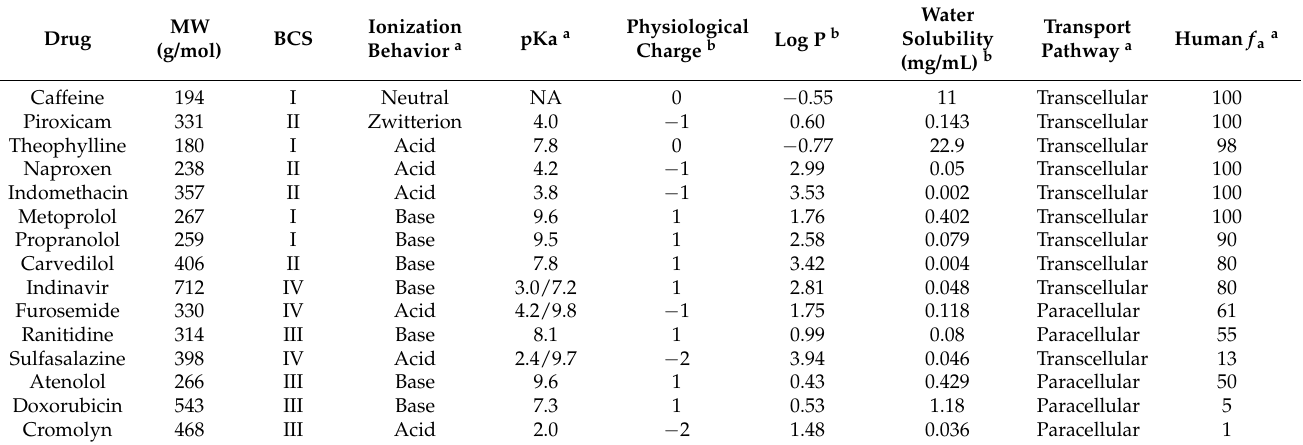
Table 1. Physicochemical properties of 15 selected reference